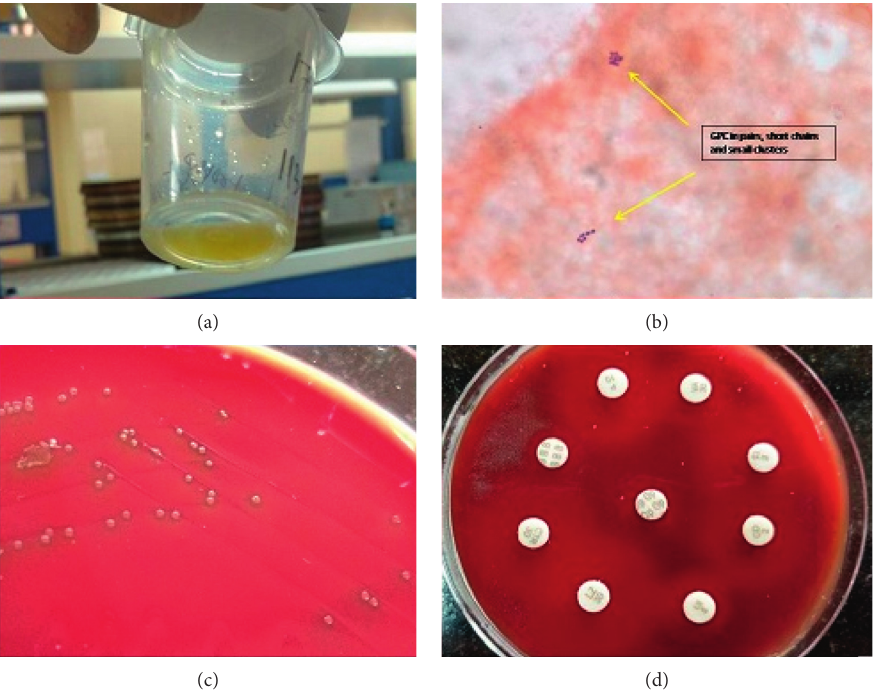
Figure 1: Liver aspirate showing (a) brownish yellow liquid pus and (b) Gram-positive cocci (GPC) arranged in pairs, short chains, and small clusters (1000x). (c) Growth of S. pneumoniae on blood agar plate and (d) susceptibility of S. pneumoniae to various antibiotics by the disc-diffusion